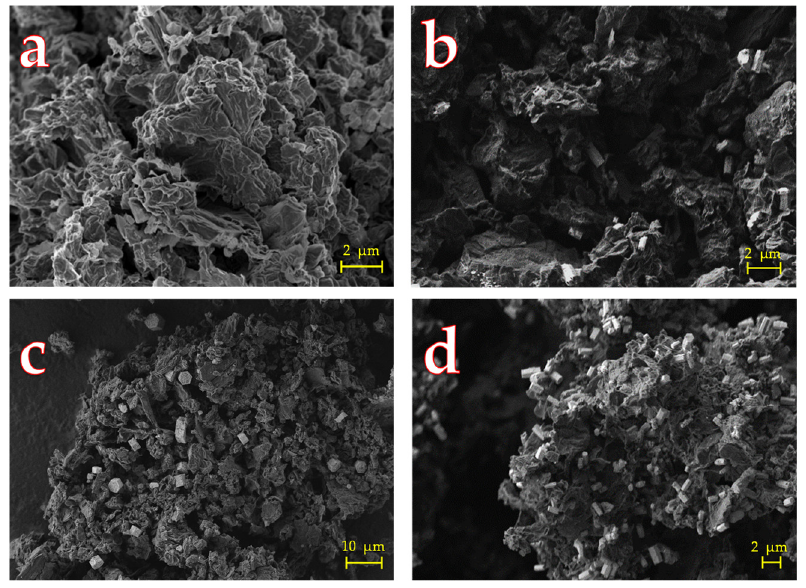
Figure 3. SEM micrograph of GO and {Ta 6 Br i12 }@GO materials: ( a ) GO, ( b ) {Ta 6 Br i12 }@GO-5L, ( c ) {Ta 6 Br i12 }@GO-20L, and ( d ) {Ta 6 Br i12 }@GO-40 L.